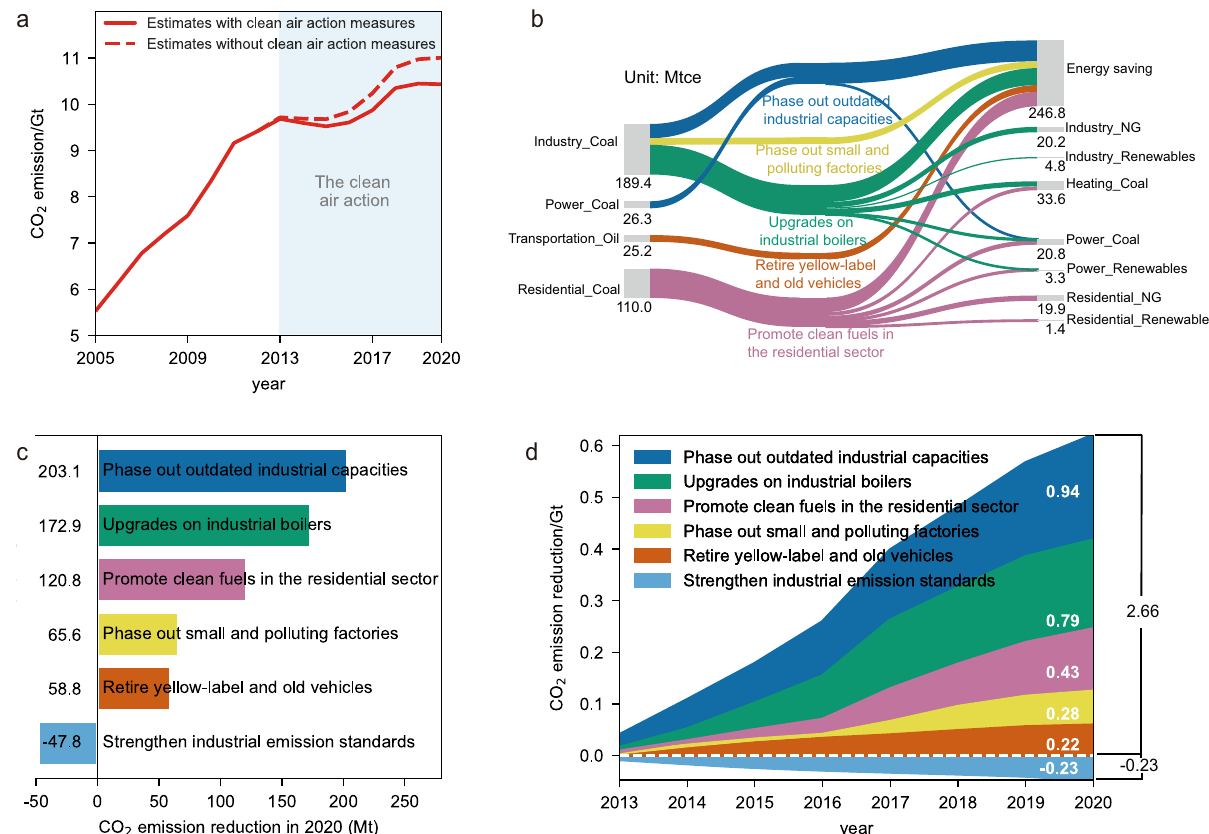
Fig. 2 | Change in China ’ s energy end-use fl ows and measure-speci fi c con- tributionstoCO 2 emissionreduction.a CO 2 emissionestimateswithandwithout clean air action measures. b Transition in energy structure in China between 2013 and 2020. The transition of energy end-use fl ows was driven by fi ve co-bene fi cial measures. The left side represents the reduction of energy consumption in 2020, and the right side represents the attribution of reduced energy consumption to